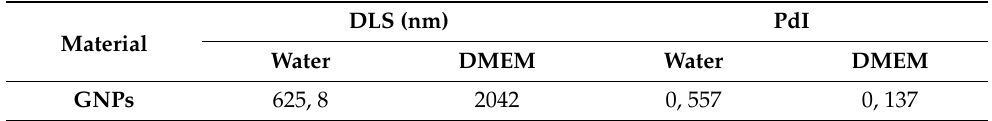
Table 2. Dynamic light scattering (DLS) particle sizes in nm and polydispersity index (PdI) values of the GNPs in water and in Dulbecco’s modified Eagle medium